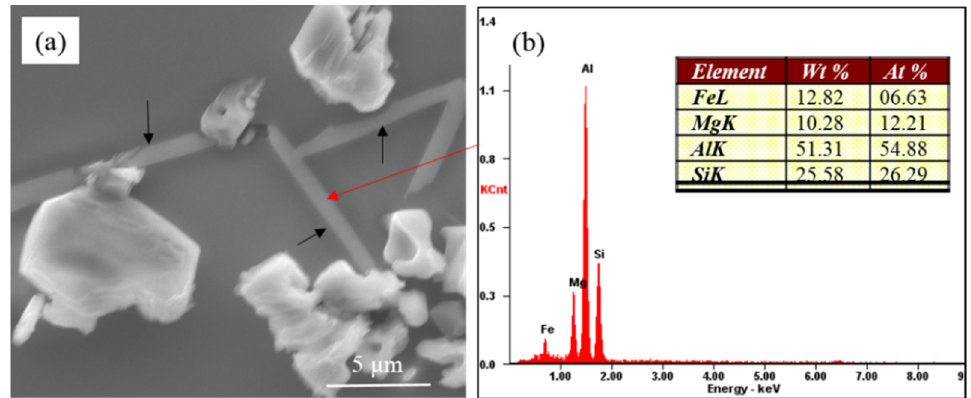
Figure 6. ( a ) Morphology of partially modified eutectic Si and Mg-rich phase in commercial pure Al-7Si-0.4Mg alloy; ( b ) Corresponding EDS results.